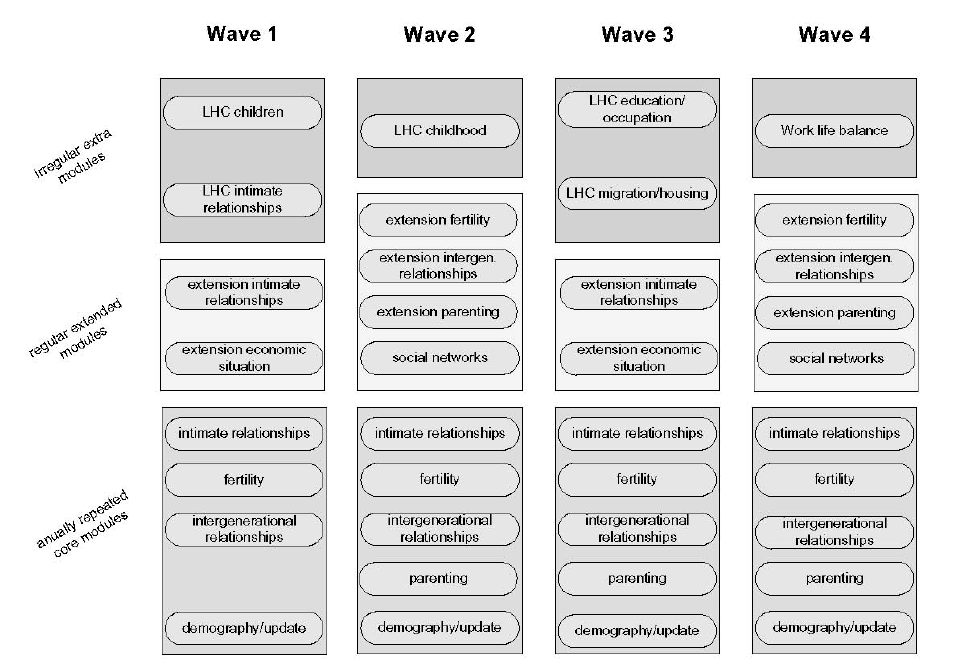
Figure 1: Modularization of the pairfam Panel